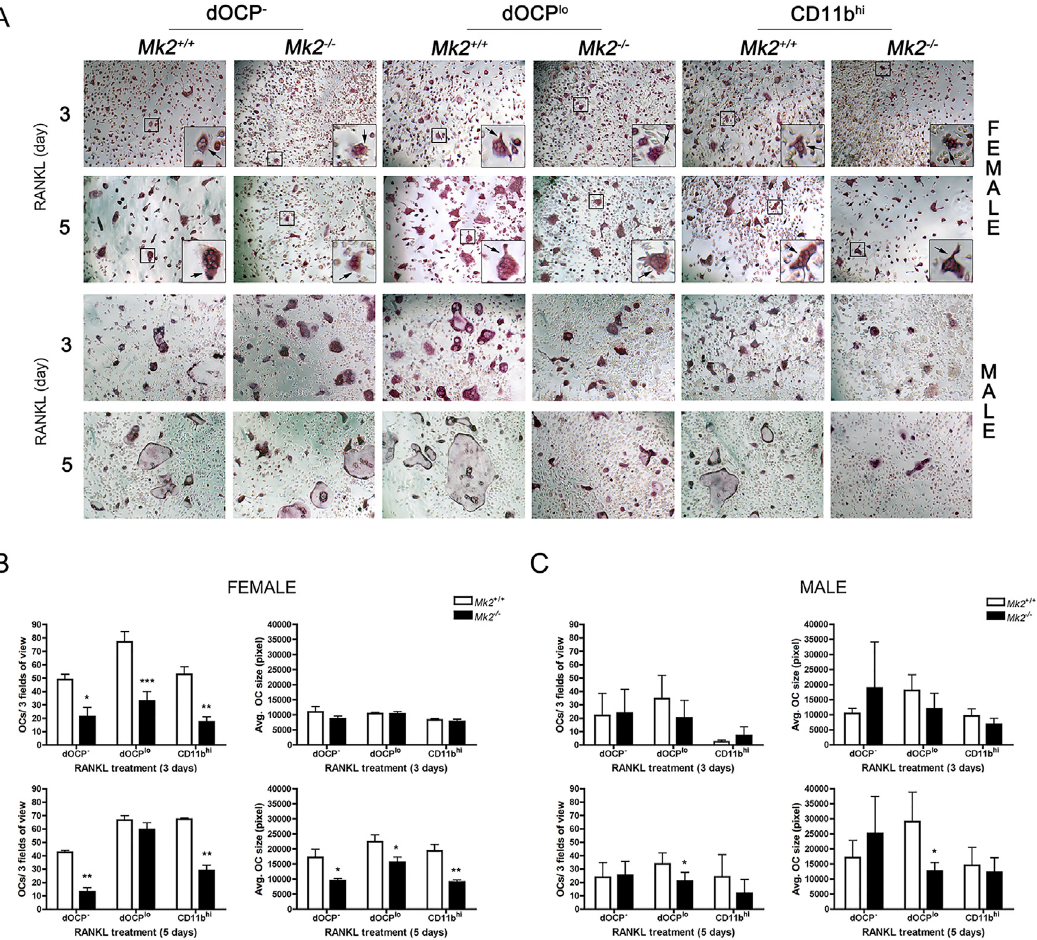
Fig 1. MK2 signaling differentially regulates osteoclast size and number from defined OCP cells. Cells were fixed, TRAP stained, and visualized by light microscopy. (A) Representative 100x images of female (top) and male (bottom) mouse bone marrow cells defined by CD11b surface expression driven to form osteoclasts (OCs) with M-CSF (25ng/mL) and RANKL (50 ng/mL). Female OCs (black arrow) were magnified 3x and inset (top). TRAP positive cells with three or more nuclei (OCs) from (B) female and (C) male mice were enumerated from three random images at days 3 (top) and 5 (bottom) of RANKL treatment. Osteoclast size from female (B, right) and male (C, right) was measured by pixels per osteoclast using Adobe PhotoShop CS. Data are expressed as means ± SE compared to Mk2 +/+ controls ( * P (cid:1) 0.05, ** P (cid:1) 0.01, *** P (cid:1)